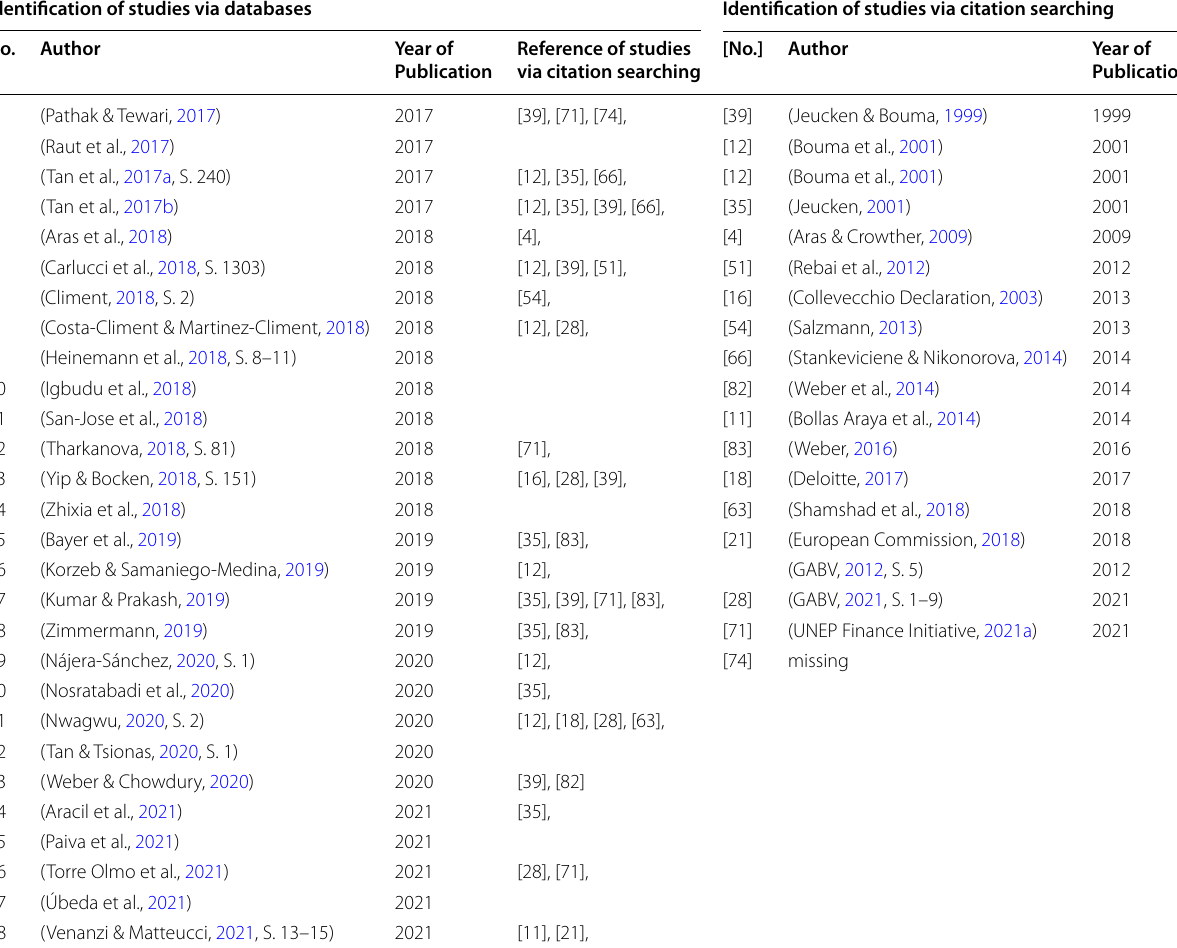
Table 2 Summary identification of relevant sources from database search and citation